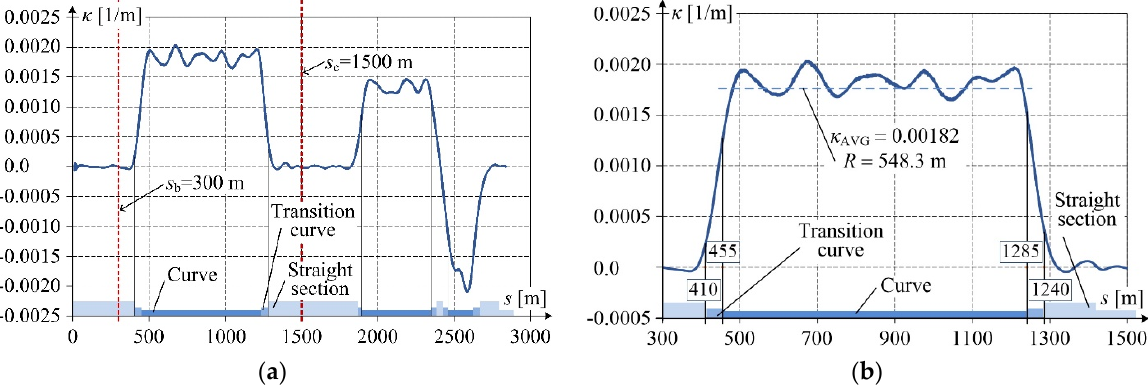
Figure 12. Track curvature determined from PL–2000 coordinates: ( a ) for the entire examined rail- way line section—selected details for the example section from s b = 300 m to s e = 1500 m are shown in figure b; ( b ) expanded fragment of a circular arc with transition curves, against data from the documentation on transition points between straight sections and transition curves, i.e., 410, 455, 1240, and 1285 m, and arc with radius R = 550 m.